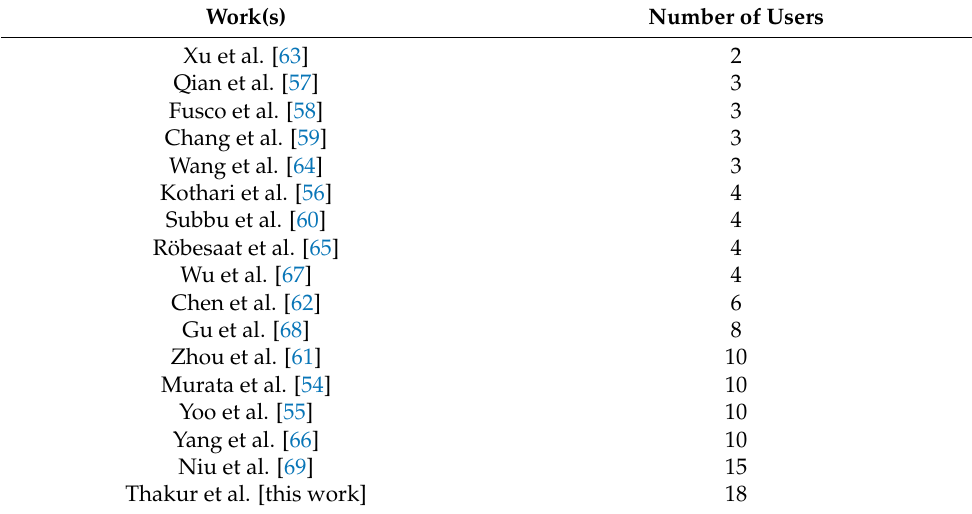
Table 6. Comparison of our proposed framework with other similar works in this field in terms of the number of users whose user interaction data were used to train the associated machine learning